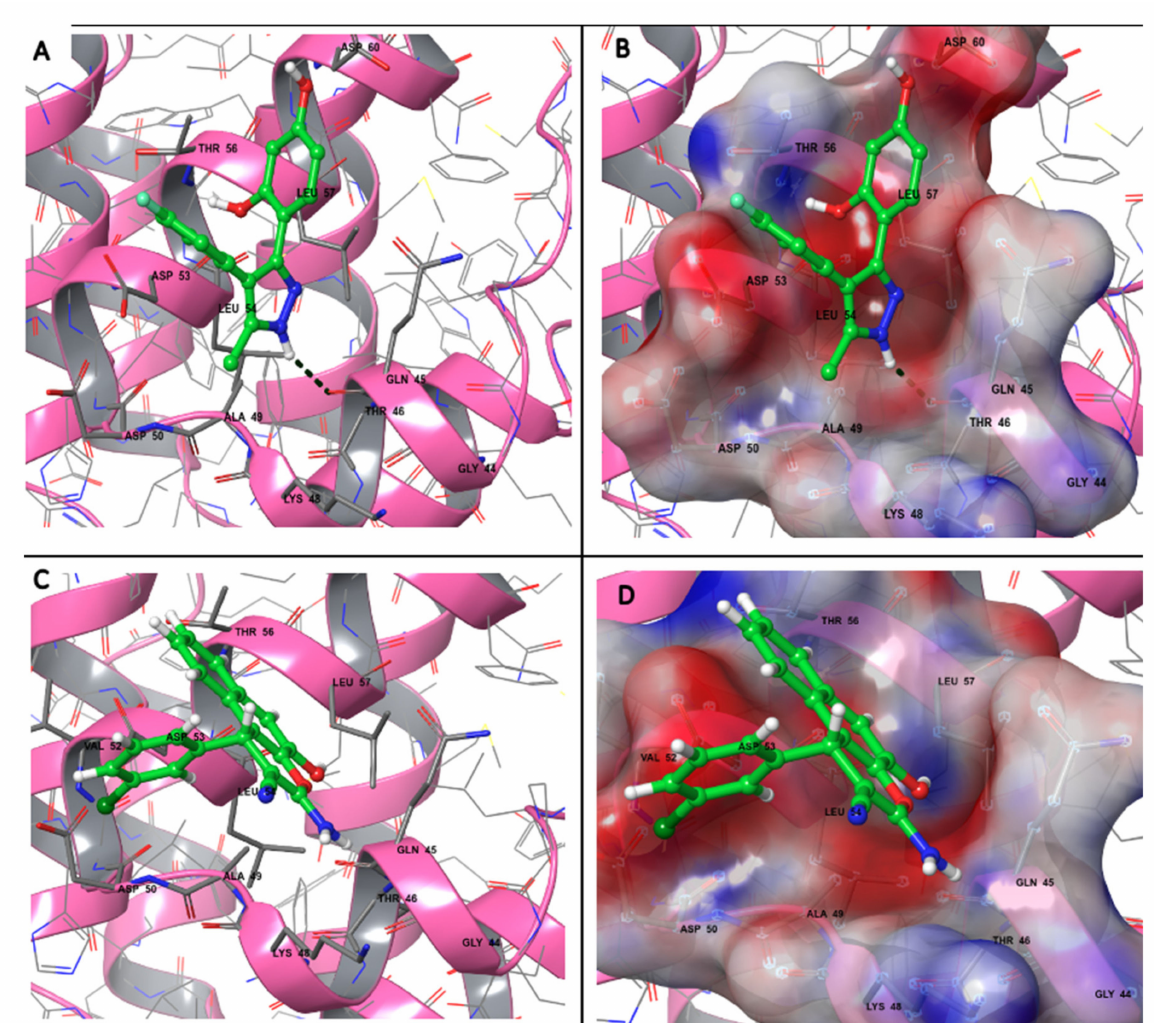
Figure 3. Molecular interactions and electrostatic surface potential of predicted binding models at the binding site (residues with 5 A ◦ distance to the ligand) for ( A , B ) QM380 and ( C , D ) QM381. The residues that interact are labeled, visualized in the ball–stick model, and colored based on their physicochemical properties. The hydrogen bond of Gln 45 and QM380 is shown as a dashed line. In panels ( B , D ), the surface ranges are characterized from positive electrostatic potential (blue surface) to a negative potential (red surface) with 30% transparency. The structures and interfaces were represented and analyzed by Maestro (version